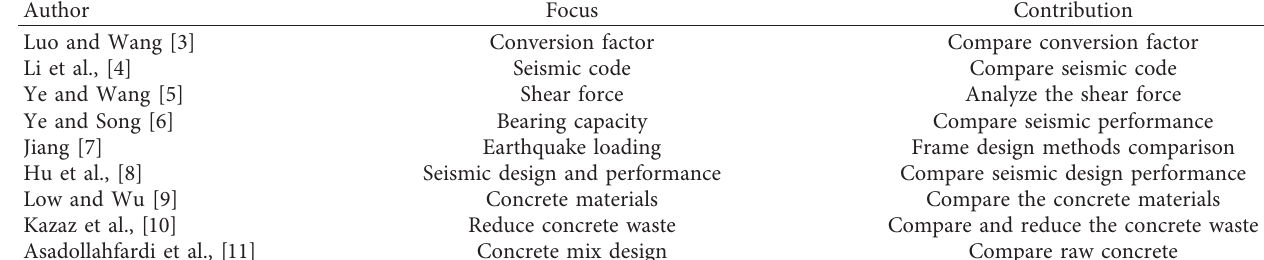
Table 1: Code comparison-related research and